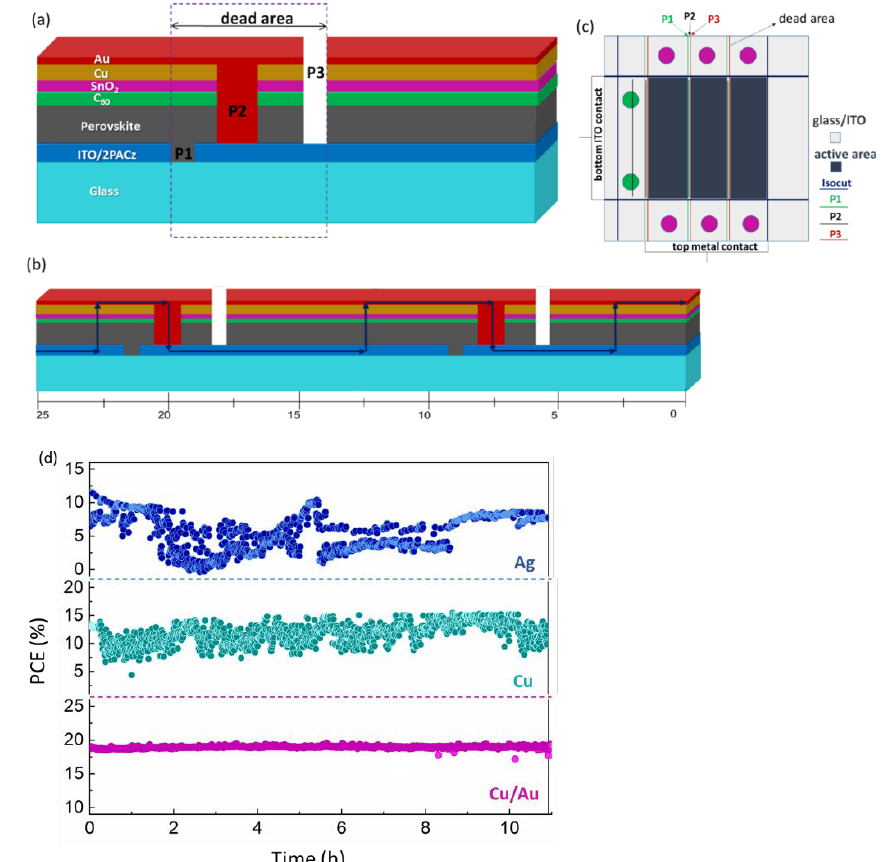
Figure 1. ( a ) The schematic device layout of p-i-n perovskite solar mini-modules with P1, P2 and P3 interconnections; ( b ) charge flow in the series connection among cells in a module; ( c ) layout of a 2.20 cm 2 module; and ( d ) long-term maximum power point tracking (MPPT) of p-i-n type perovskite solar modules (PSMs) with different metal top electrodes, such as Ag, Cu and Cu/Au, while measured under simulated 1-sun illumination.